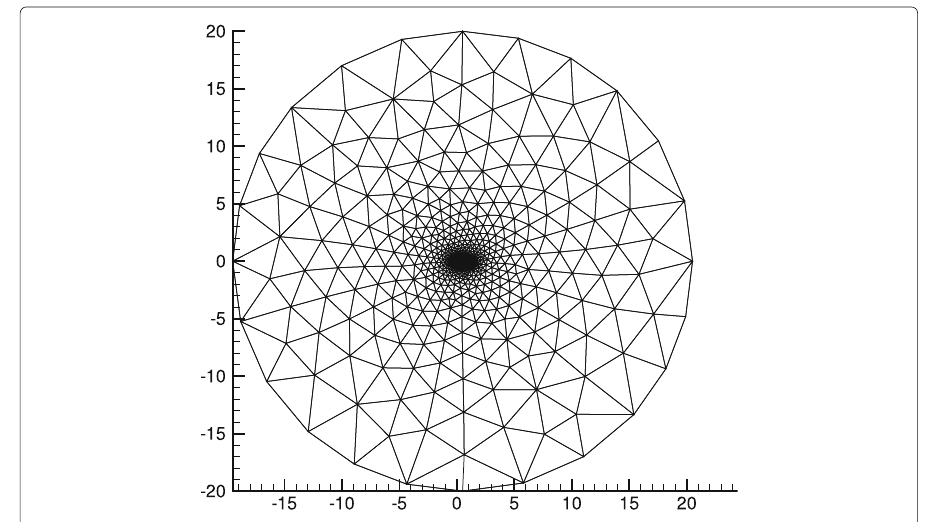
origin x 0 , y 0 0, 0 , thus pitching axis at x p , y p 0.25, 0 . The initial mesh and zoomed-in grids near the airfoil at two different angles of attack are shown in Figs. 8 and 9, respectively. Given the above harmonic motion for the points at wall boundary and the static points at the far-filed boundary, the movement of the interior nodes is inter- polated from the RBF method. With the airfoil motion and the flow field being periodic, the unsteady solutions after a reasonably long time of computation should be used for analysis.